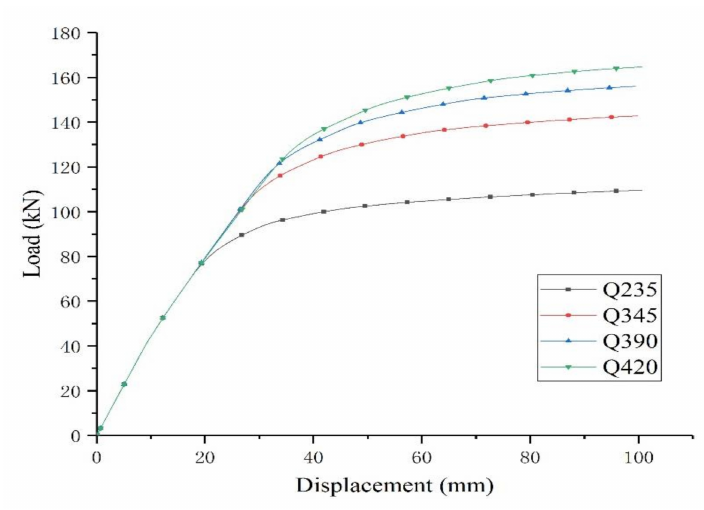
Figure 20. Load displacement curves of different steel